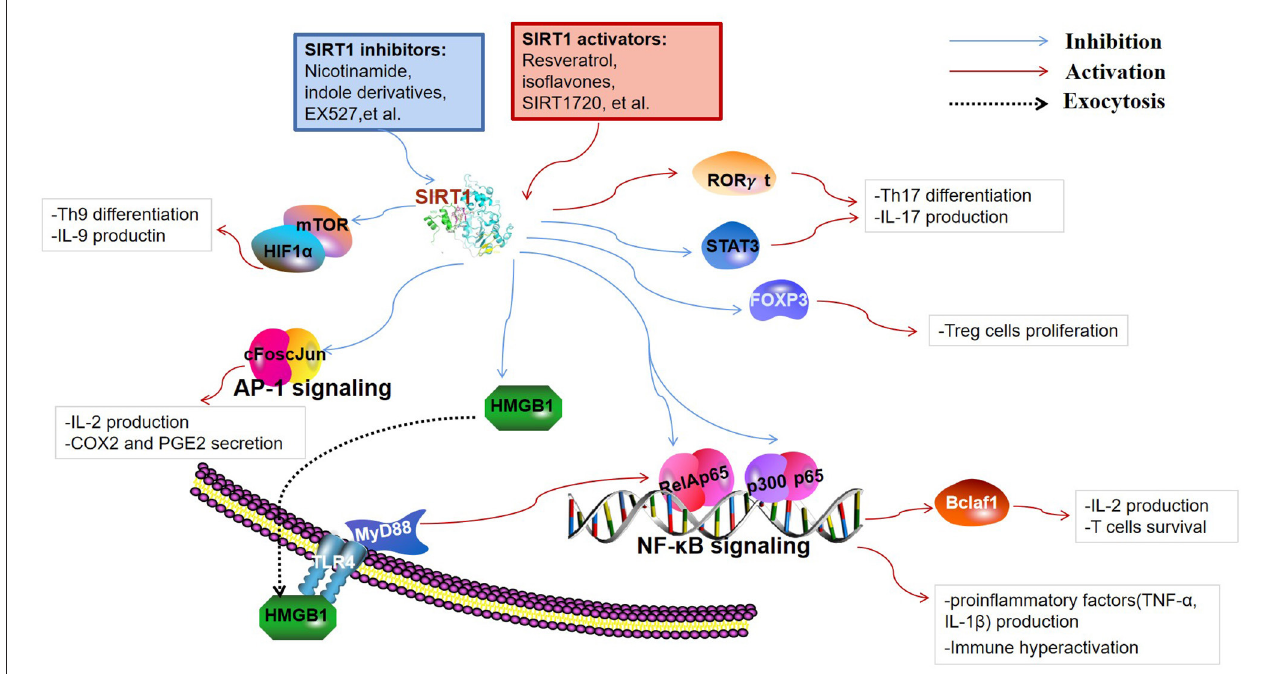
FIGURE 2 | Targets of SIRT1 in the immune responses. SIRT1 inhibits immune activity via deacetylation of multiple targets. Nuclear factor κ -light-chain-enhancer of activated B cells (NF- κ B) and activator protein 1 (AP-1) are key transcription factors involved in the production of inflammatory cytokines and immune hyperactivation. B-cell lymphoma 2-associated factor 1 (Bclaf1) was found to be regulated by NF- κ B, which is associated with immune cell survival. SIRT1 restrains the high-mobility group box 1 (HMGB1) exocytosis to exert protective and anti-inflammatory effects by inhibiting the HMGB1/TLR4/MyD88/NF- κ B signaling pathway. Fork head box P3 (FOXP3), signal transducer and activator of transcription 3 (STAT3), and retinoid acid receptor-related orphan receptor gamma t (ROR γ t) are pivotal regulators of T cell differentiation into regulatory T cells (Tregs) and Th17 cells. Th9 cell differentiation and the release of IL-9 are regulated through SIRT1-mTOR-HIF1 α signaling.